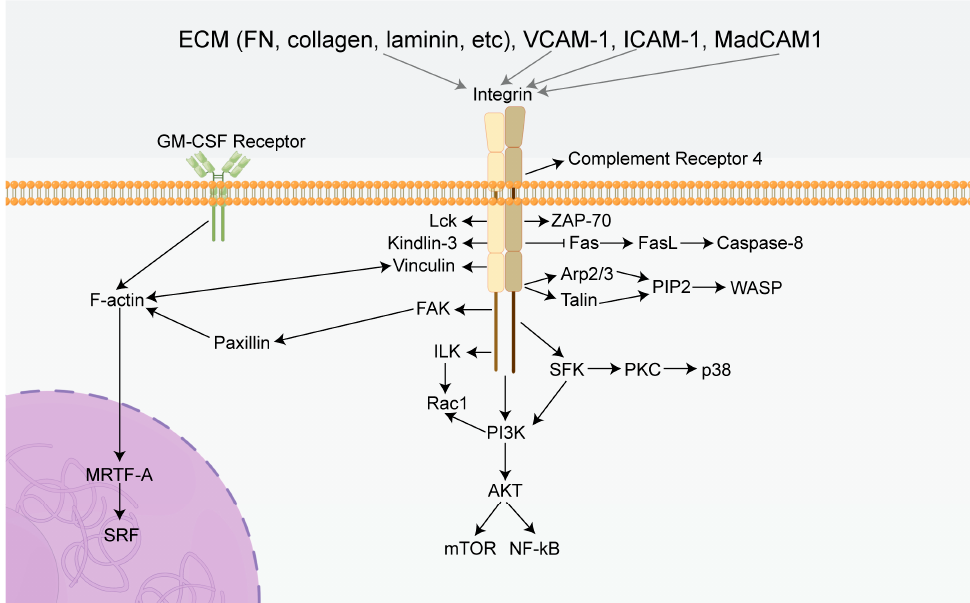
Figure 2. Summary diagram of the effects of integrins in immune cells. Integrins can mediate several classical signaling pathways, including PI3K/AKT/mTOR, ILK/Rac1, and Fas/FasL. Activation of these specific pathways leads to a cascade reaction inducing the characteristics of immune cells, including proliferation, survival, migration, adhesion, and immunotolerance. FN: Fibronectin, GM-CSF Receptor: Granulocyte-macrophage colony-stimulating factor receptor, FAK: Focal adhesion kinase, PI3K: Phosphatidylinositol 3-phosphokinase, AKT: Protein kinase B, mTOR: Mammalian target of rapamycin, ILK: Integrin-linked kinase, Rac1: Rac Family Small GTPase, Fas: TNF receptor superfamily, FasL: Ligand of TNF receptor superfamily, PIP2: phosphatidylinositol (1,2,3) -triphos- phate, Arp2/3: Actin nucleating protein complex, WASP: Wisco tt aldridge syndrome protein, MRTF- A: Myocardin-related transcription factor-A, SRF: Serum response factor, SFK: SRC-Family protein tyrosine kinase, VCAM-1: Vascular cell adhesion molecule 1, ICAM-1: intercellular adhesion mole- cule 1, MadCAM1: Mucosal address in cell-adhesion molecule-1, Lck: Protein tyrosine kinase, ZAP- 70: Zeta chain associated protein of 70 kDa, PKC: Protein kinase C, NF-kB: Nuclear factor-k-gene binding.